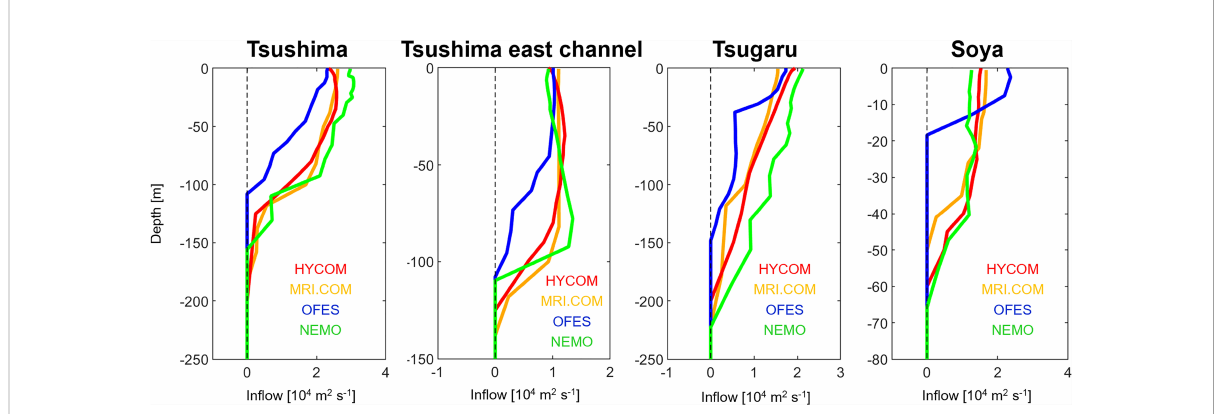
FIGURE 10 Vertical pro fi les of horizontally integrated velocities per unit depth along the Tsushima Strait, Tsugaru Strait, Soya Strait, as well as along the east channel of the Tsushima Strait only (between Tsushima Island and Japan) as simulated by the ocean models HYCOM (red), MRI.COM (orange), NEMO (green), and OFES (blue) for the time period from 1993 to